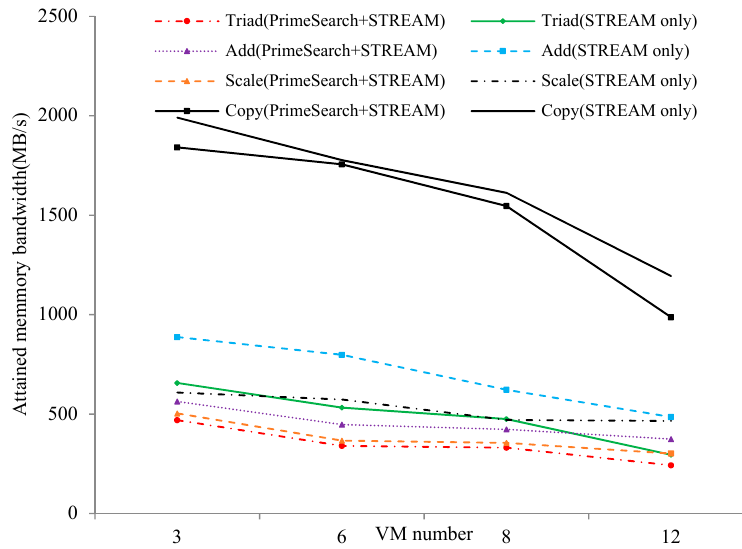
Figure 16. Maximum memory access bandwidth (server #3).